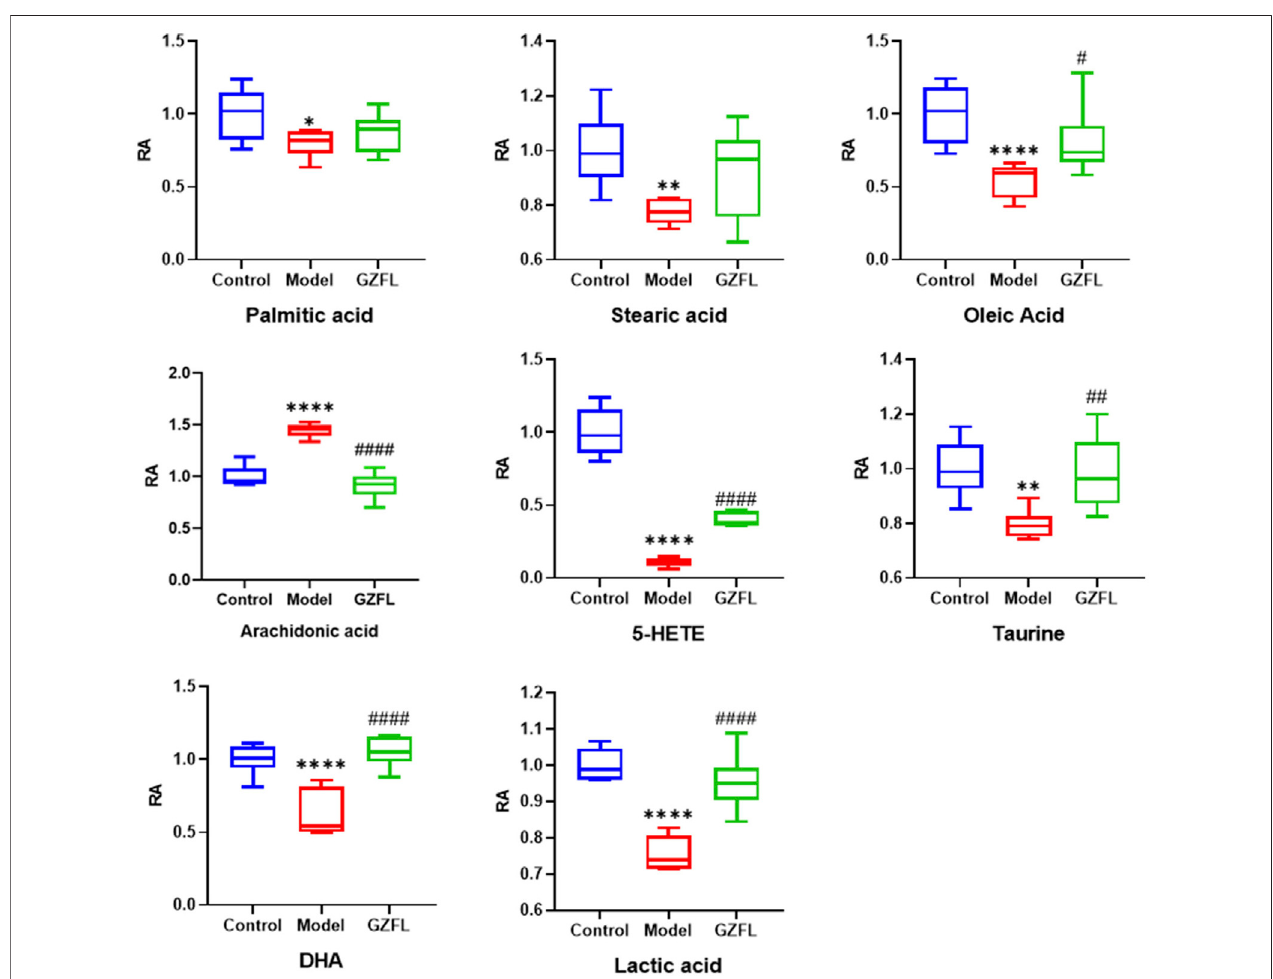
FIGURE7| Relativeabundance(RA)ofthedifferentialmetabolites(x ± s ,n (cid:2) 6,compared withblankcontrolgroup:* p < 0.05** p < 0.01*** p < 0.001 **** p < 0.0001; compared with the model group: # p < 0.05 ## p < 0.01 ### p < 0.001 #### p < 0.0001).